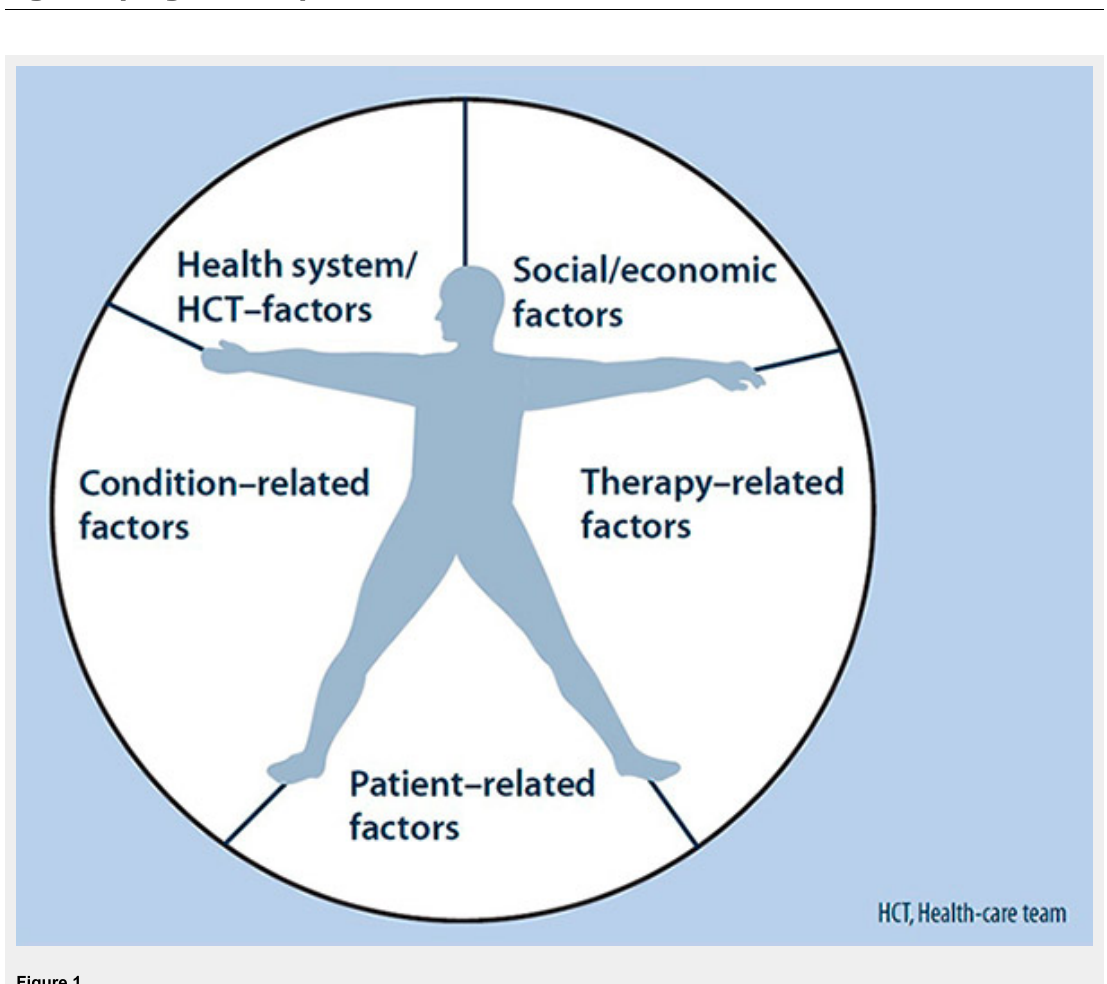
The five dimensions of adherence (reproduced with the permission of the WHO from Sabaté E (2003)